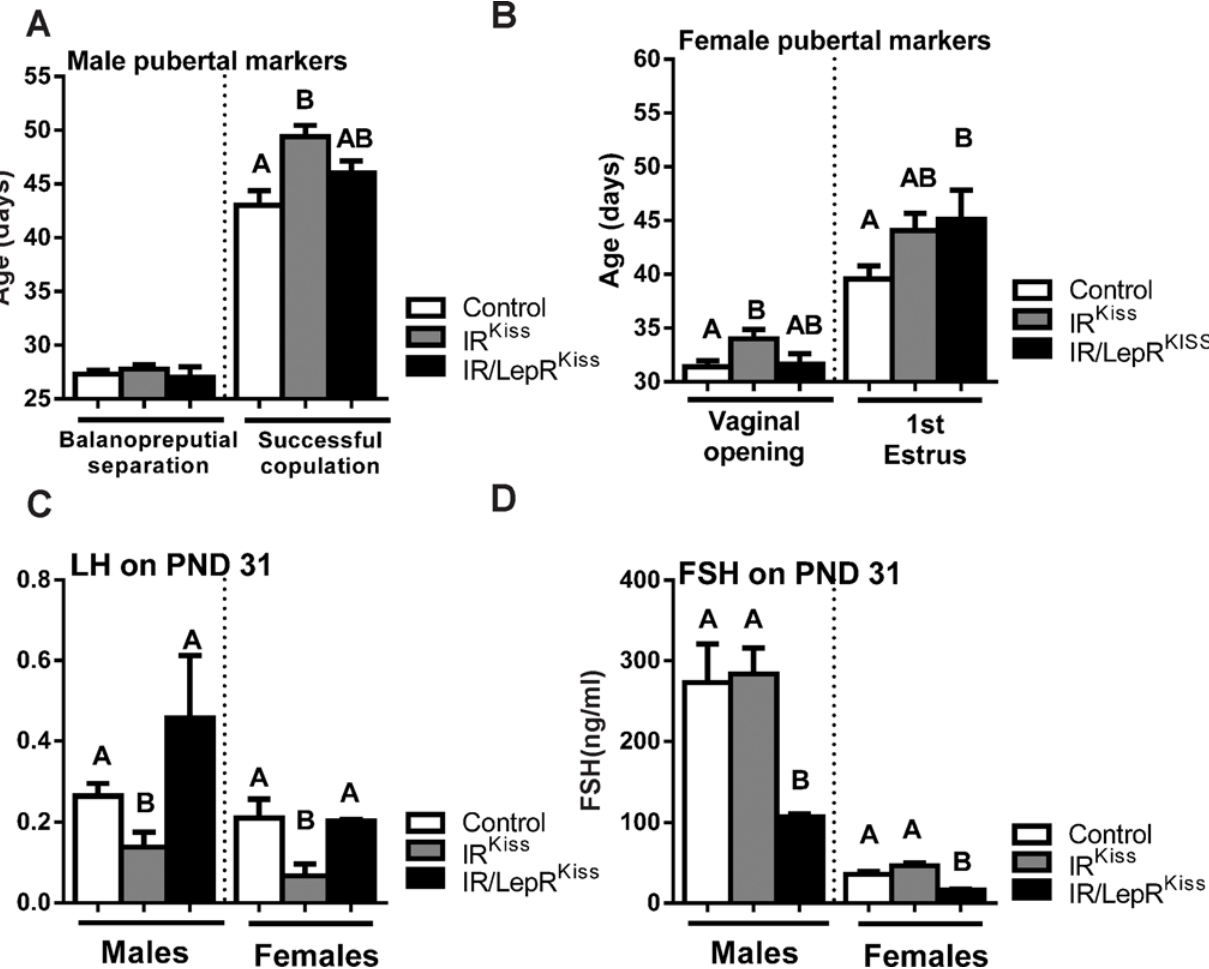
Fig 6. Puberty in IR/LepR Kiss mice. (A) Balanopreputial separation age in male control (n = 12), IR Kiss (n = 10) and IR/LepR Kiss (n = 3) mice. Estimated age of sexual maturation calculated by subtraction of 20 days from the time required for delivery of a litter sired by male control (n = 8), IR Kiss (n = 10) and IR/ LepR Kiss (n = 4) mice. (B) Vaginal opening and first estrus was evaluated in female control (n = 9 – 12), IR Kiss (n = 10) and IR/LepR Kiss (n = 7 – 8) mice. (C) LH serum levels on postnatal day 31 in male control (n = 7) and IR/LepR Kiss (n = 7) mice and female control (n = 10) and IR/LepR Kiss (n = 6) mice. (D) FSH serum levels on postnatal day 31 in male control (n = 7) and IR/LepR Kiss (n = 7) mice and in female control (n = 10) and IR/LepR Kiss (n = 6)